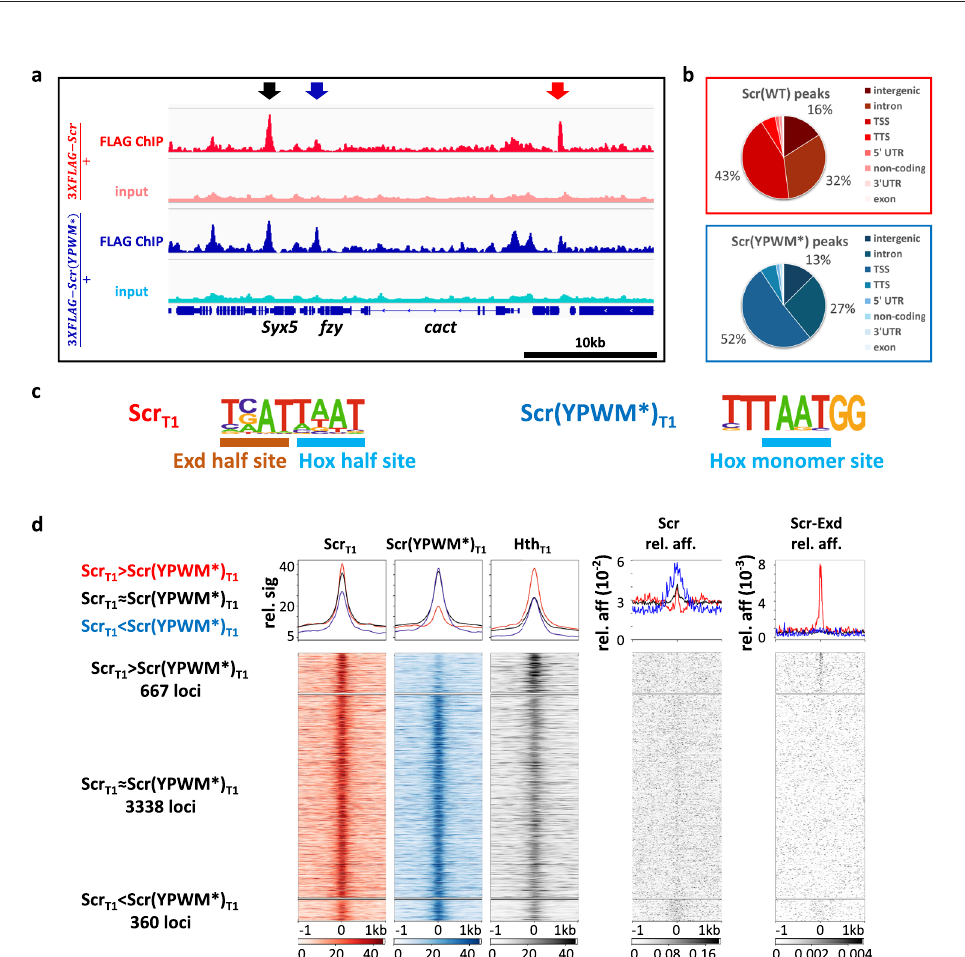
Fig. 3 Generation and phenotypic characterization of a YPWM-mutated Scr allele. a Schematic showing Scr-Exd interaction mediated by Scr ’ s YPWM motif. The gray bar denotes DNA. b Schematic (not to scale) of the 3xFLAG-Scr(YPWM*) allele. Colors are de fi ned in Fig. 1; the YPWM-> AAAA mutation (YPWM*) is highlighted in yellow. The direction of transcription is indicated by an arrow at the TSS. c Left: CrebA is expressed in the embryonic salivary gland in wild-type embryos. Middle: CrebA expression in salivary gland is absent in homozygous Scr null embryos. Right: CrebA is also absent in the salivary gland of homozygous Scr(YPWM*) embryos. The arrows point to the position of wild-type CrebA expression domain. d The number of sex comb teeth in males of various genotypes. The x axis is the number of sex comb teeth per leg, and the y axis shows the number of legs. The average and the range of sex comb teeth numbers for each genotype are also shown. e The suppression of sternopleural bristles (Sp bristles) in the T1 segment does not require Scr ’ s YPWM motif. Left: wild type. Sp bristles are in T2 but not T1 segment. Middle: adult with homozygous Scr null clones in T1. Consistent with previous fi ndings 4 , Sp bristles are observed when Scr is absent (22 out of 28 adults with the correct genotype have Sp bristles in T1; see “ Methods ” for details). Right: adult with homozygous Scr(YPWM*) clones in T1 segment. The Sp bristles are not observed (0 out of 16 adults with the correct genotype have Sp bristles in T1). White and black ovals indicate the equivalent regions of the T1 and Sp-bearing T2 segments, respectively. f Co-immunostaining of Ac, a marker for proneural clusters, and Hth proteins in T1 and T2 leg discs in the wandering larva stage. White arrows point to the Ac + proneuronal clusters for the Sp bristles in the Hth domain of T2 leg discs, and yellow arrows point to the Ac- homologous positions in T1 leg discs, where the proneural cluster is suppressed by Scr. Scale bar: 100 μ m.